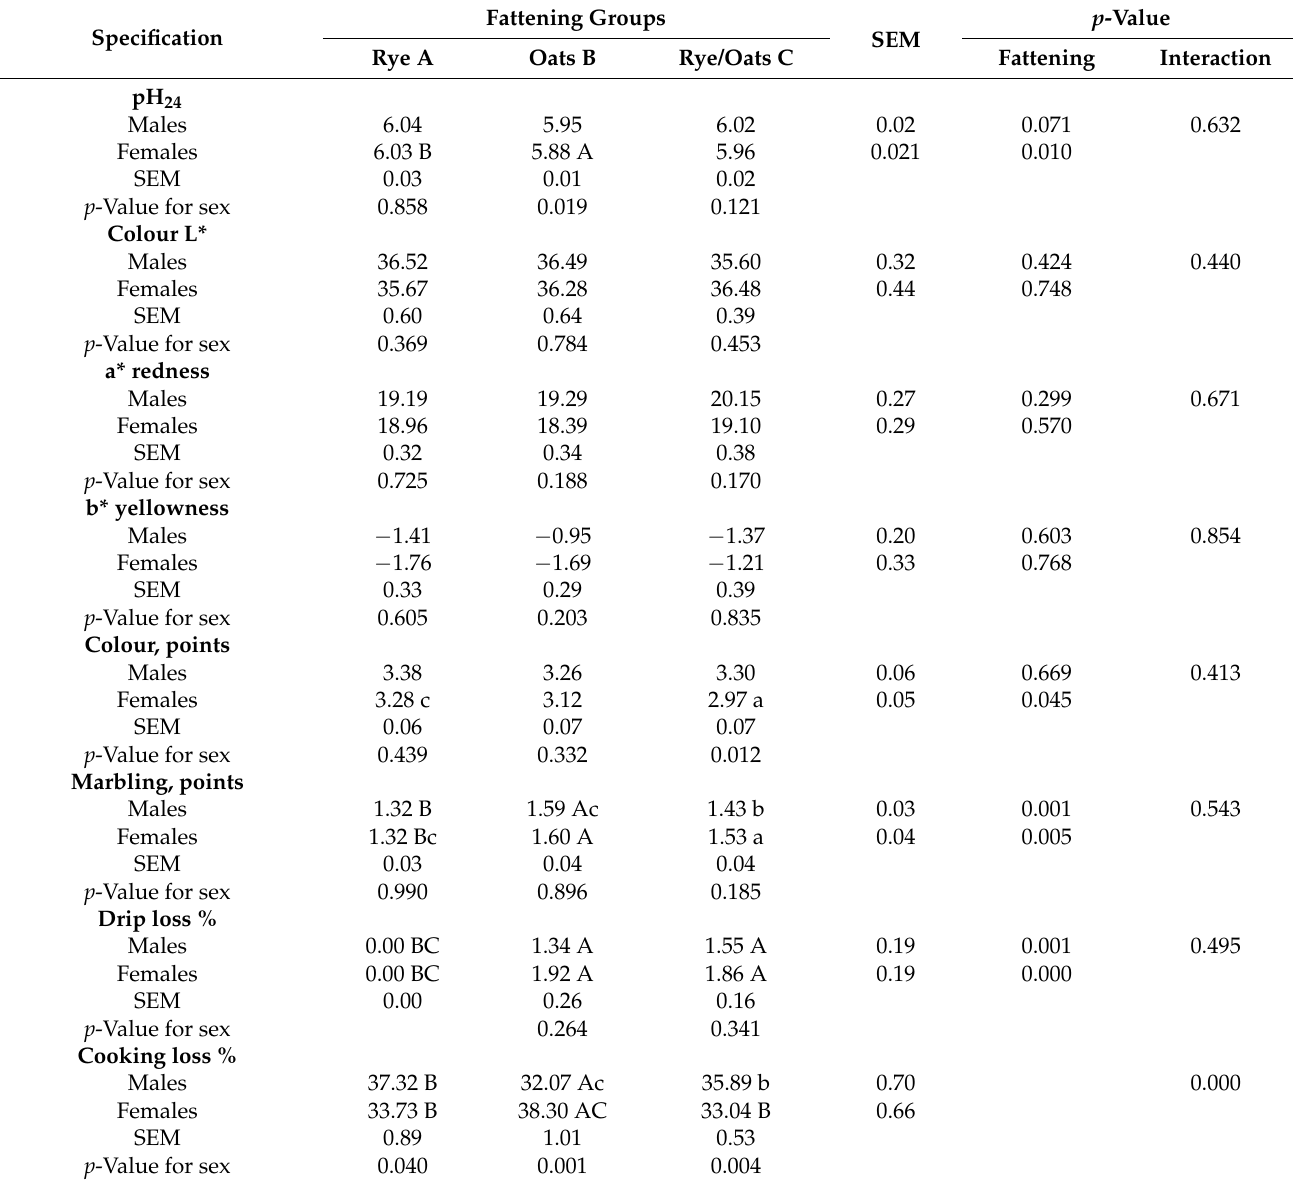
Table 6. Selected physical parameters of breast